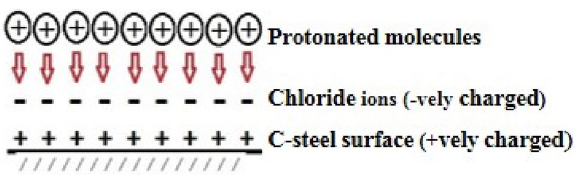
Figure 14. Schematic representation of inhibition